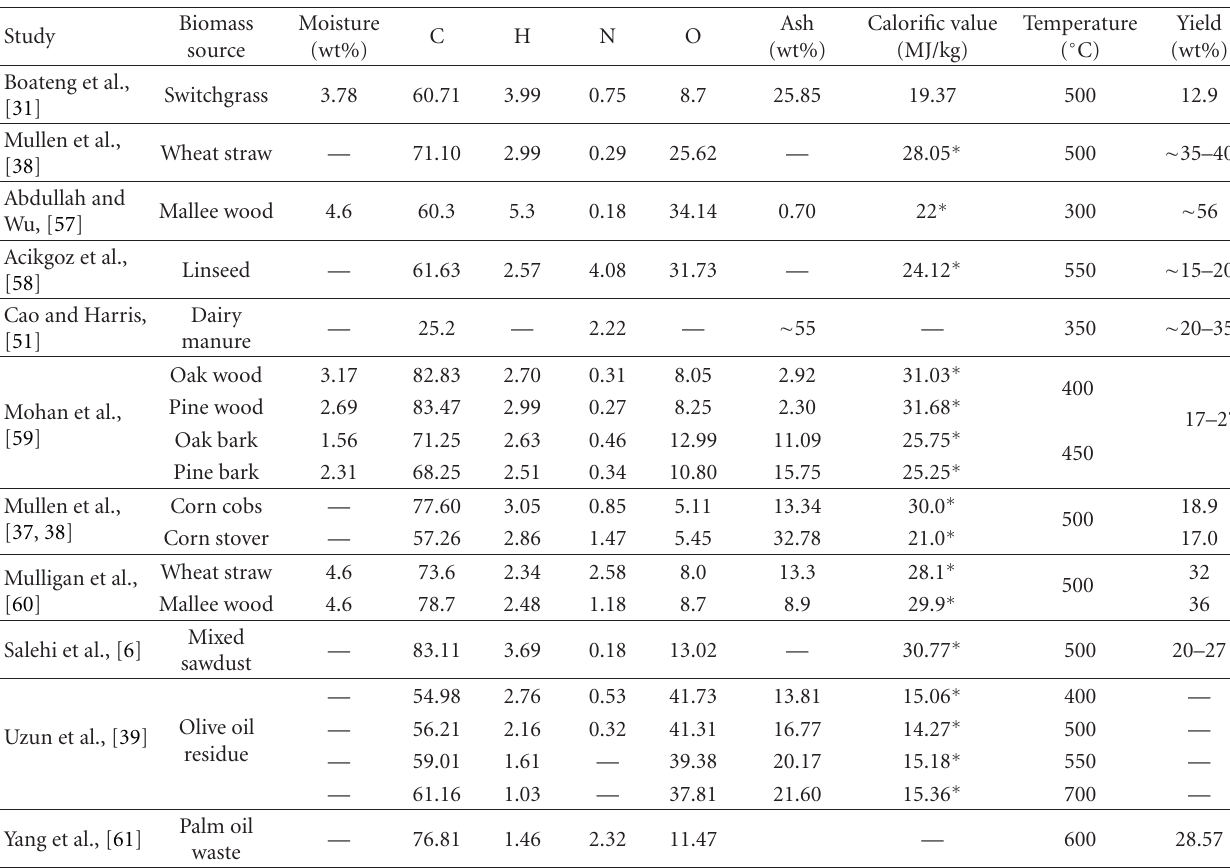
Table 3: Characteristics of biochar produced by di ff erent processes/biomass